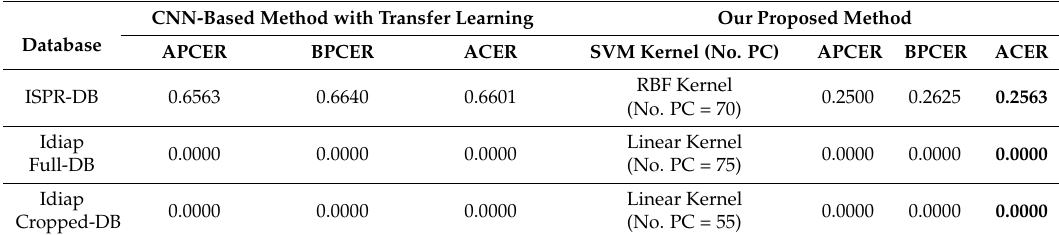
Table 18. Detection errors of CNN-based method and our proposed method using customized Alex network in Table 3 (unit: %).